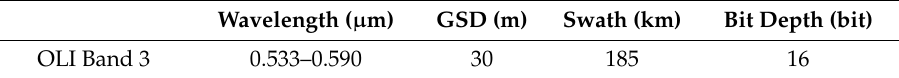
Table 2. Specifications of base-map image of OLI (Band 3) onboard